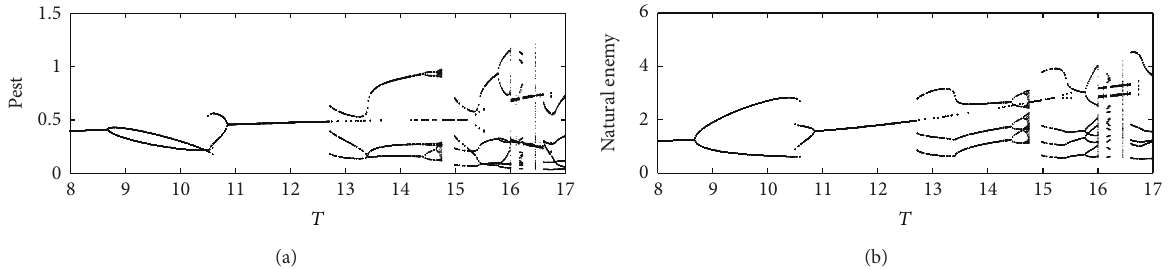
Figure 6: The bifurcation diagram of stable periodic solution of system (1) with 𝑎(𝑡) = 1/(50 + 15 sin (3𝑡)) , 𝑏(𝑡) = 0.5 , 𝑐(𝑡) = 0.5 , 𝛿(𝑡) = 0.4 , = 0.7 , 𝜎 = 0.5 . (a) The bifurcation diagram of pest for system (1); (b) the bifurcation diagram of natural enemy for system 𝑟(𝑡) = 0.5 , 𝑝 1 1